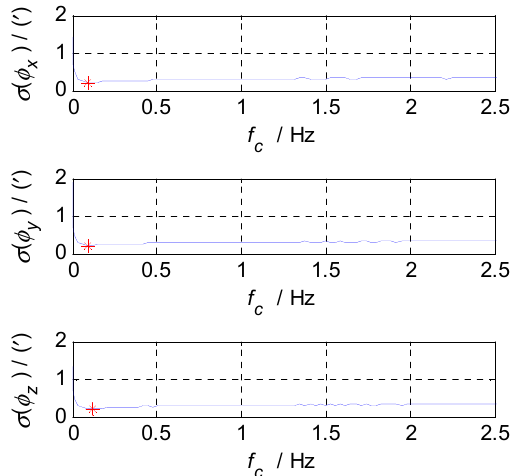
and σ ( φ i ) . 1 ( ) σφ . i